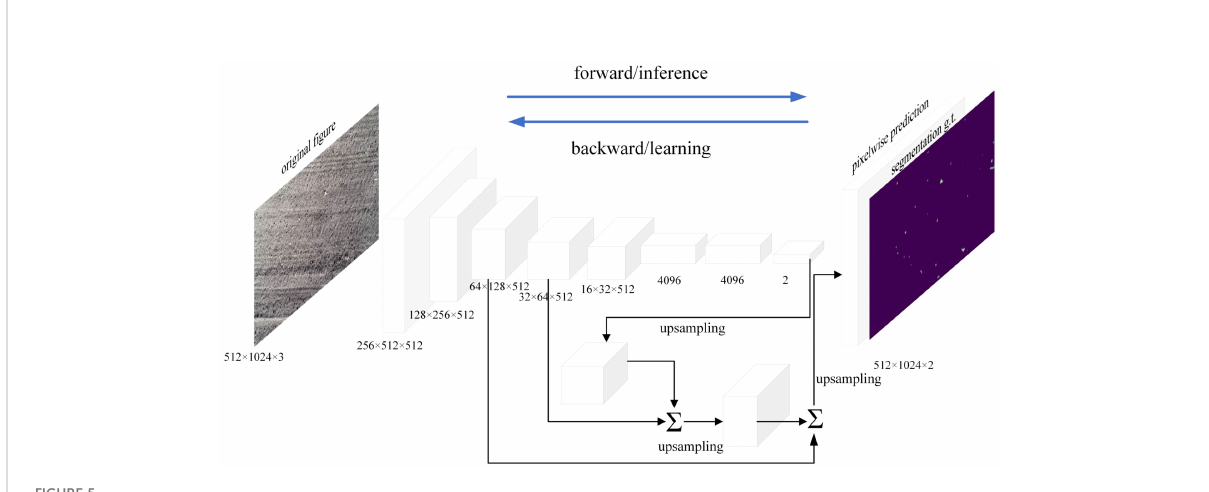
FIGURE 5 Schematic diagram of the FCN